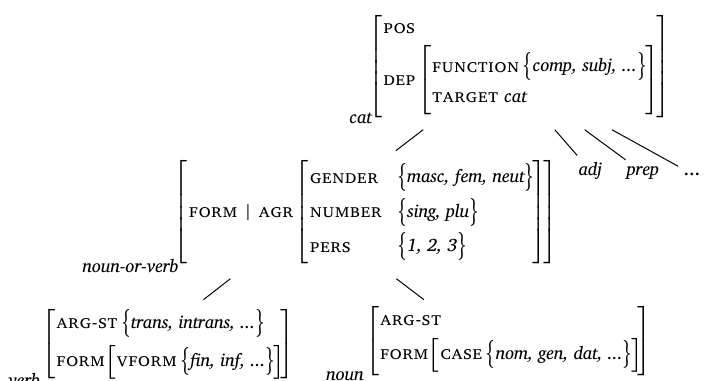
Figure 2: Inheritance in nominal and verbal